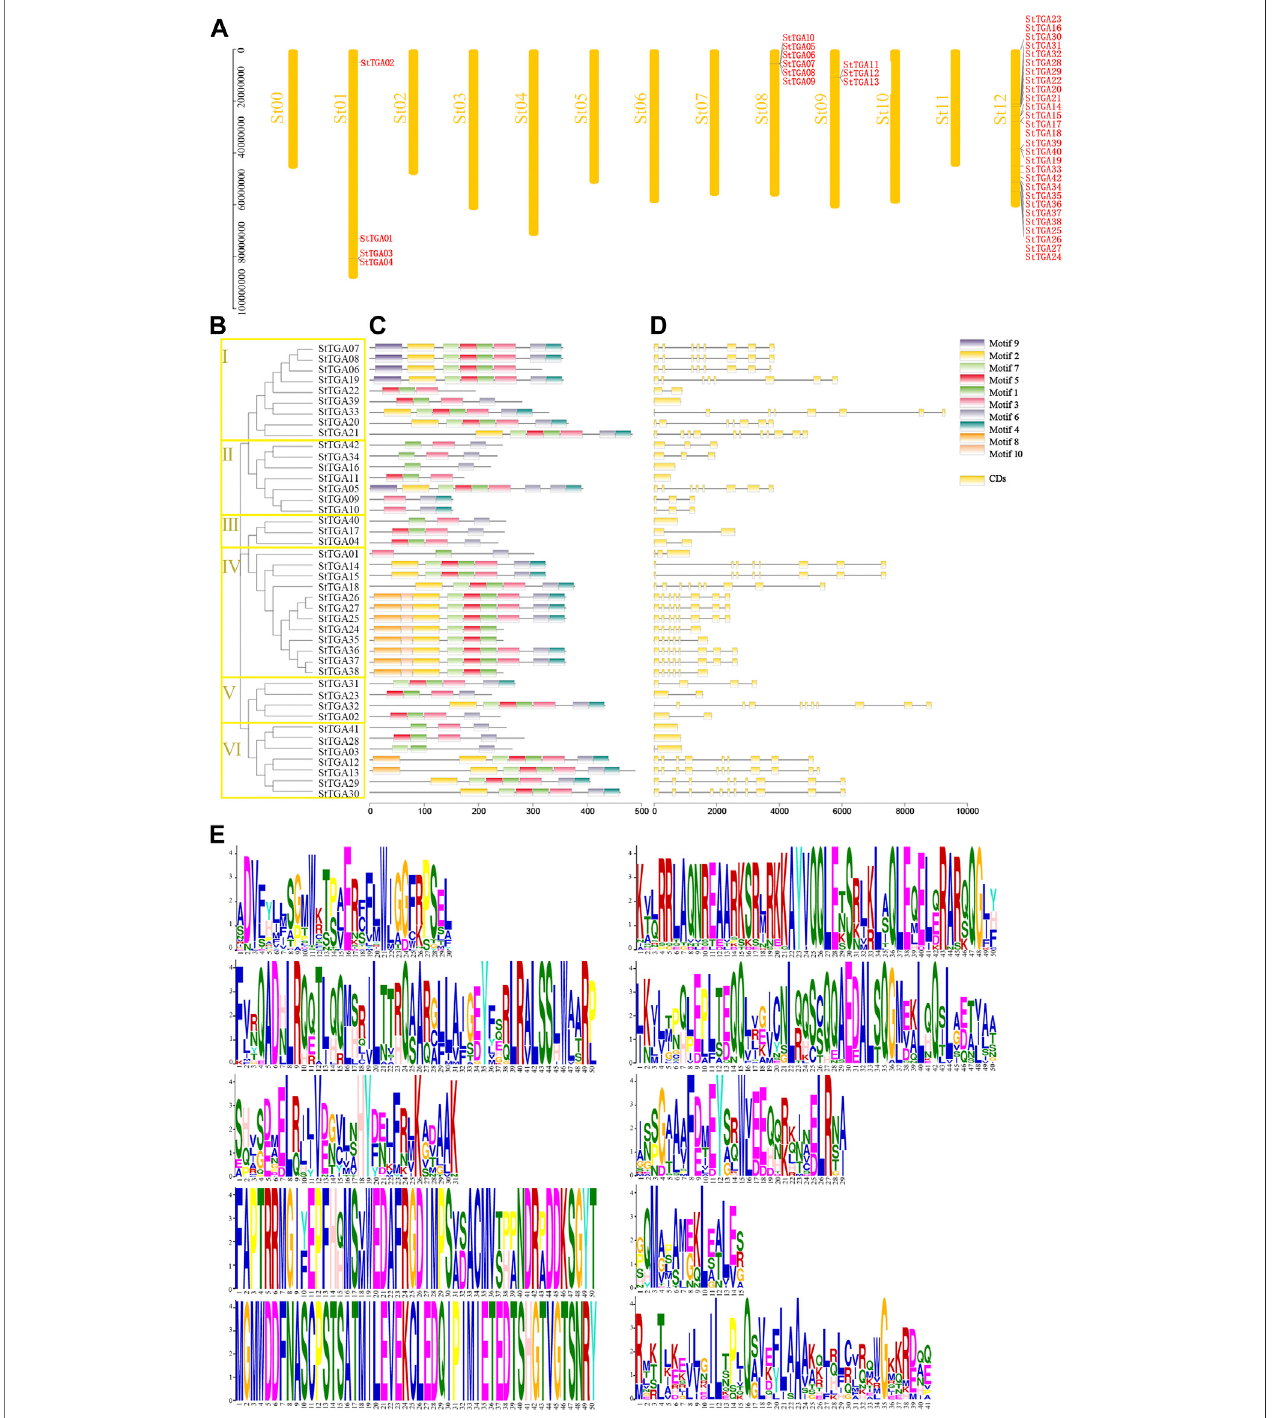
FIGURE1| Chromosomallocation,phylogeneticrelationship,exon – intronstructure,andconservedmotifanalysisofStTGAprotein. (A) Chromosomallocationsof StTGA genes. The gene names of StTGA are shown in red to the right of the chromosome. (B) Phylogenetic tree of potato StTGA based on its amino acid sequence. Branch lines with different colors indicated different subgroups. The proteins on the tree can be divided into six distinct subfamilies, which are indicated by different colored backgrounds. (C) Conserved motif of StTGA proteins analyzed by online program MEME server. Different colored boxes indicated different motifs. (D) Genestructure of StTGA .The exon – intron structure of StTGA genesvisualized byonlinetool GSDS2.0, yellow boxes indicatedexons,and black lines indicated introns. (E) Amino acid composition of 10 conserved motifs.